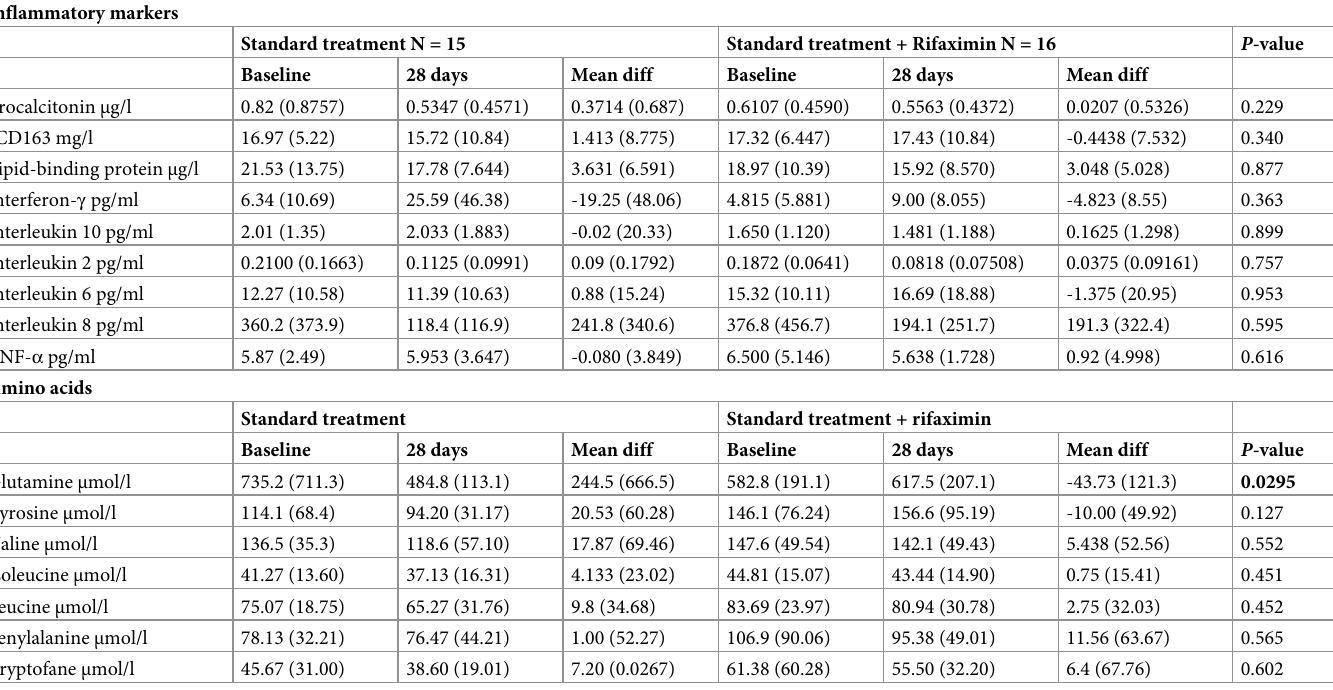
Table 3. Primary outcomes of inflammation and metabolism.